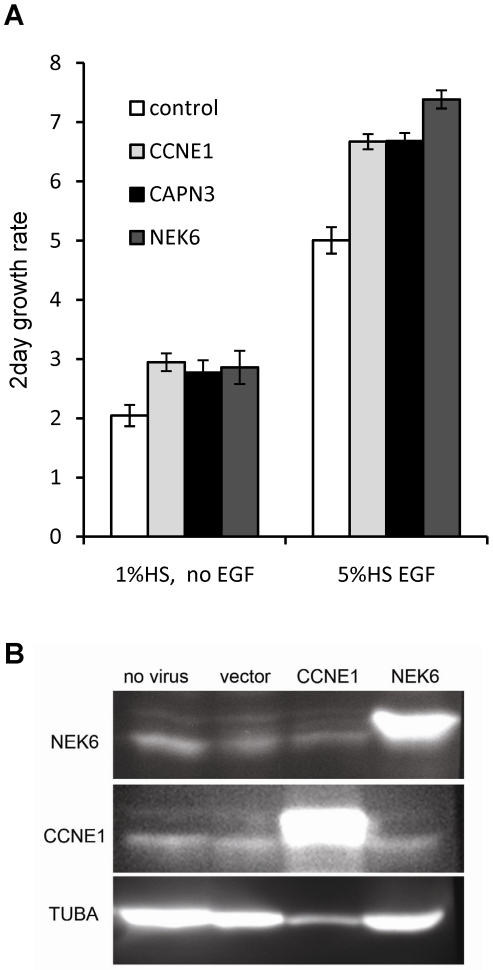
Effect of transgene overexpression on 2-day growth rate of FACS-purified cell populations.MCF-10A cells were transduced with control (truncated CPNE3), CCNE1, CAPN3 or NEK6 vectors and sorted by flow cytometry for GFP expression (minimum 98% GFP positive cells). A- Cells were seeded in complete medium (5%HS and EGF), and the next day media were replaced with either reduced (1% HS no EGF) or complete medium. Cells were counted 1 and 3 days later and ratios calculated. Bars represent mean of 4 wells and error bars show the standard deviation. B – Western blots of whole cell protein extracts obtained from sorted cell lines after one freeze-thaw cycle and 8 subsequent passages. Targeted antigen is indicated on the left of the image while the introduced ORF is indicated on top of each lane. Except for the no virus control, cells used were confirmed to be >98% GFP positive prior to harvesting.